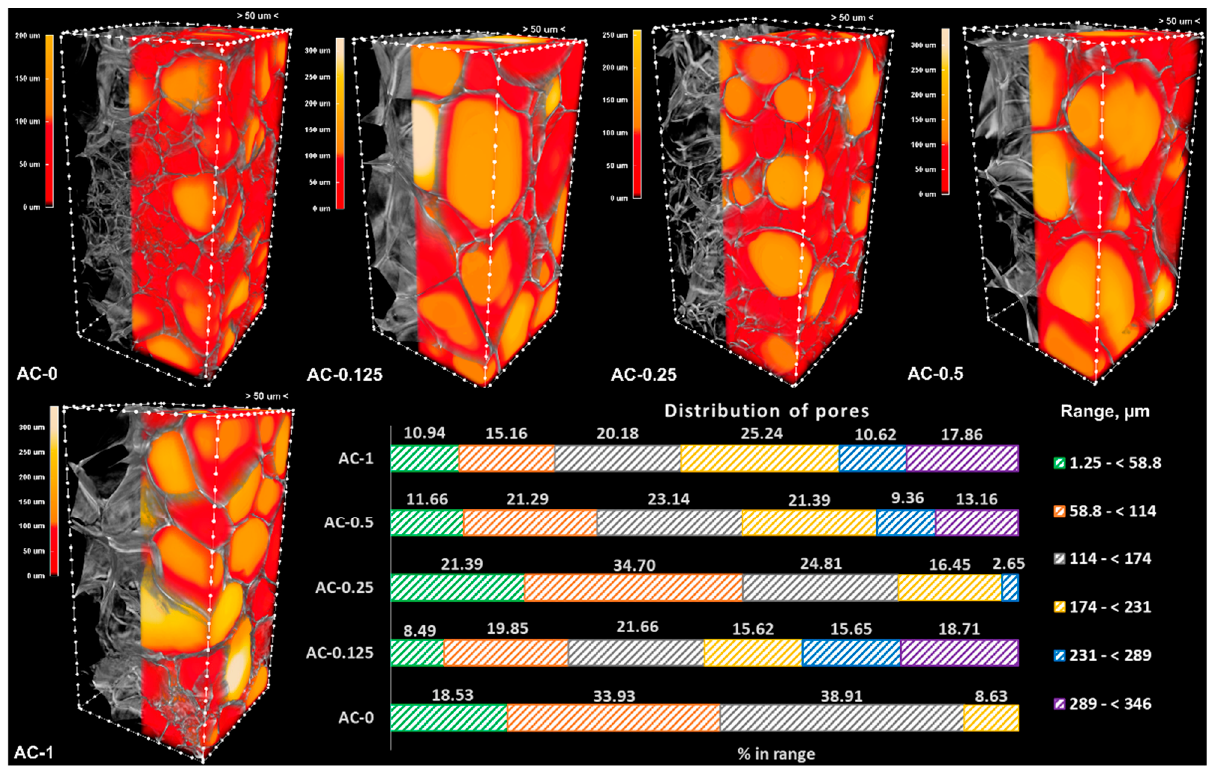
Figure 3. Three-dimensional images of the AC samples and graphical representation of the porosity measurements.